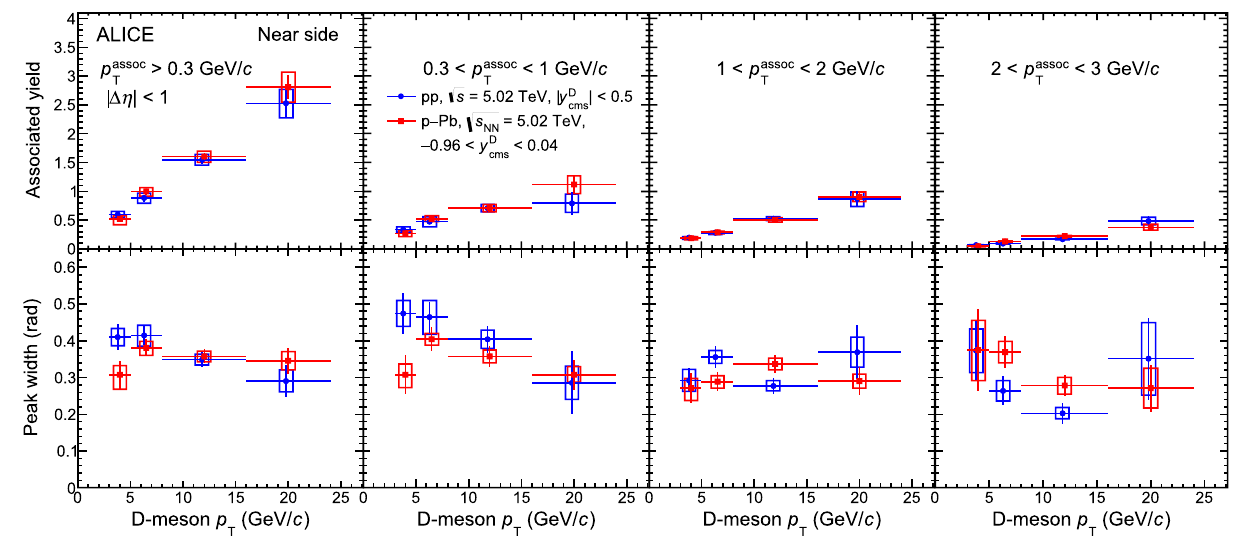
< 3 GeV / c (from left to right). Statistical and system- Fig. 4 Near-side peak associated yields (top row) and widths (bot- and 2 < p assoc √ T s = 5 . 02 TeV and p–Pb colli- tom row) in pp collisions at atic uncertainties are shown as vertical error bars and boxes, respec- √ s NN = 5 . 02 TeV, as a function of the D-meson p T , for tively. The points and error boxes for pp collisions are shifted by sions at > 0 . 3 GeV / c , 0 . 3 < p assoc < 1 GeV / c , 1 < p assoc < 2 GeV / c , = − 0 . 2 GeV / c (cid:4) p p assoc T T T T